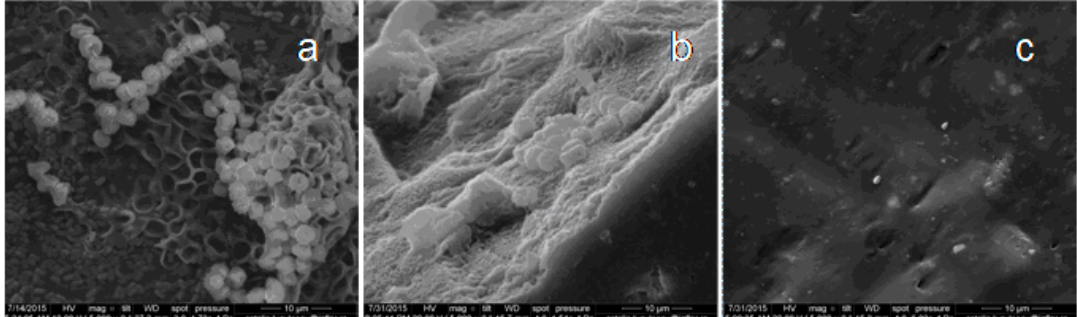
Figure 21. SEM of the C-2 composite. ( a ) after 60 days of incubation with Aspergillus niger ; ( b ) after 60 days of incubation with Aspergillus niger and after 72 h immersed in toluene; ( c ) the blanks (before incubation with the Aspergillus niger ) and after 72 h immersed in toluene.